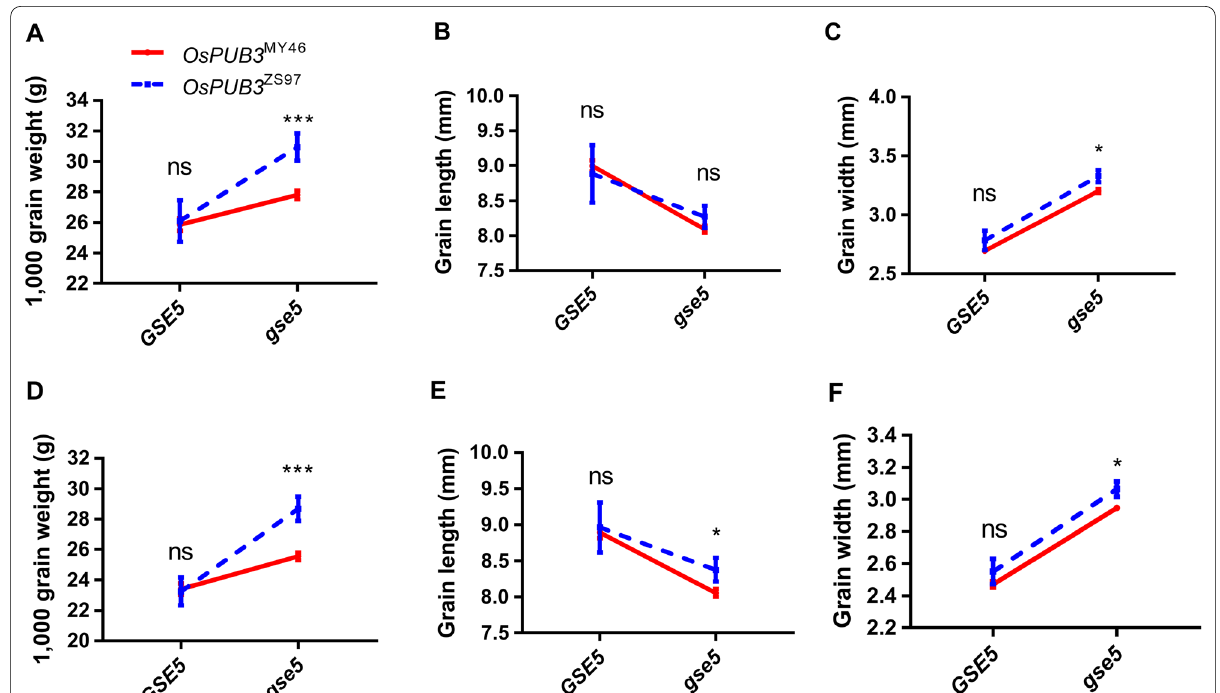
Fig. 3 The effects of OsPUB3 on three grain‑size traits in the background of functional GSE5 and non‑functional gse5 , respectively. A – C Three traits measured in Lingshui trial. D – F Three traits measured in Hangzhou trial. Values are given as the mean OsPUB3 MY46 , n 7 for OsPUB3 ZS97 ; ges5 background: n =